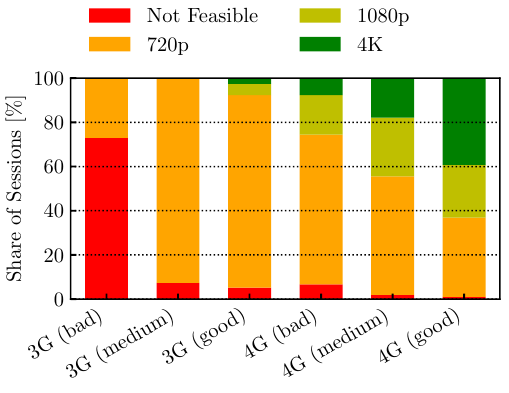
Figure 5. Estimated resolution of Stadia sessions on mobile